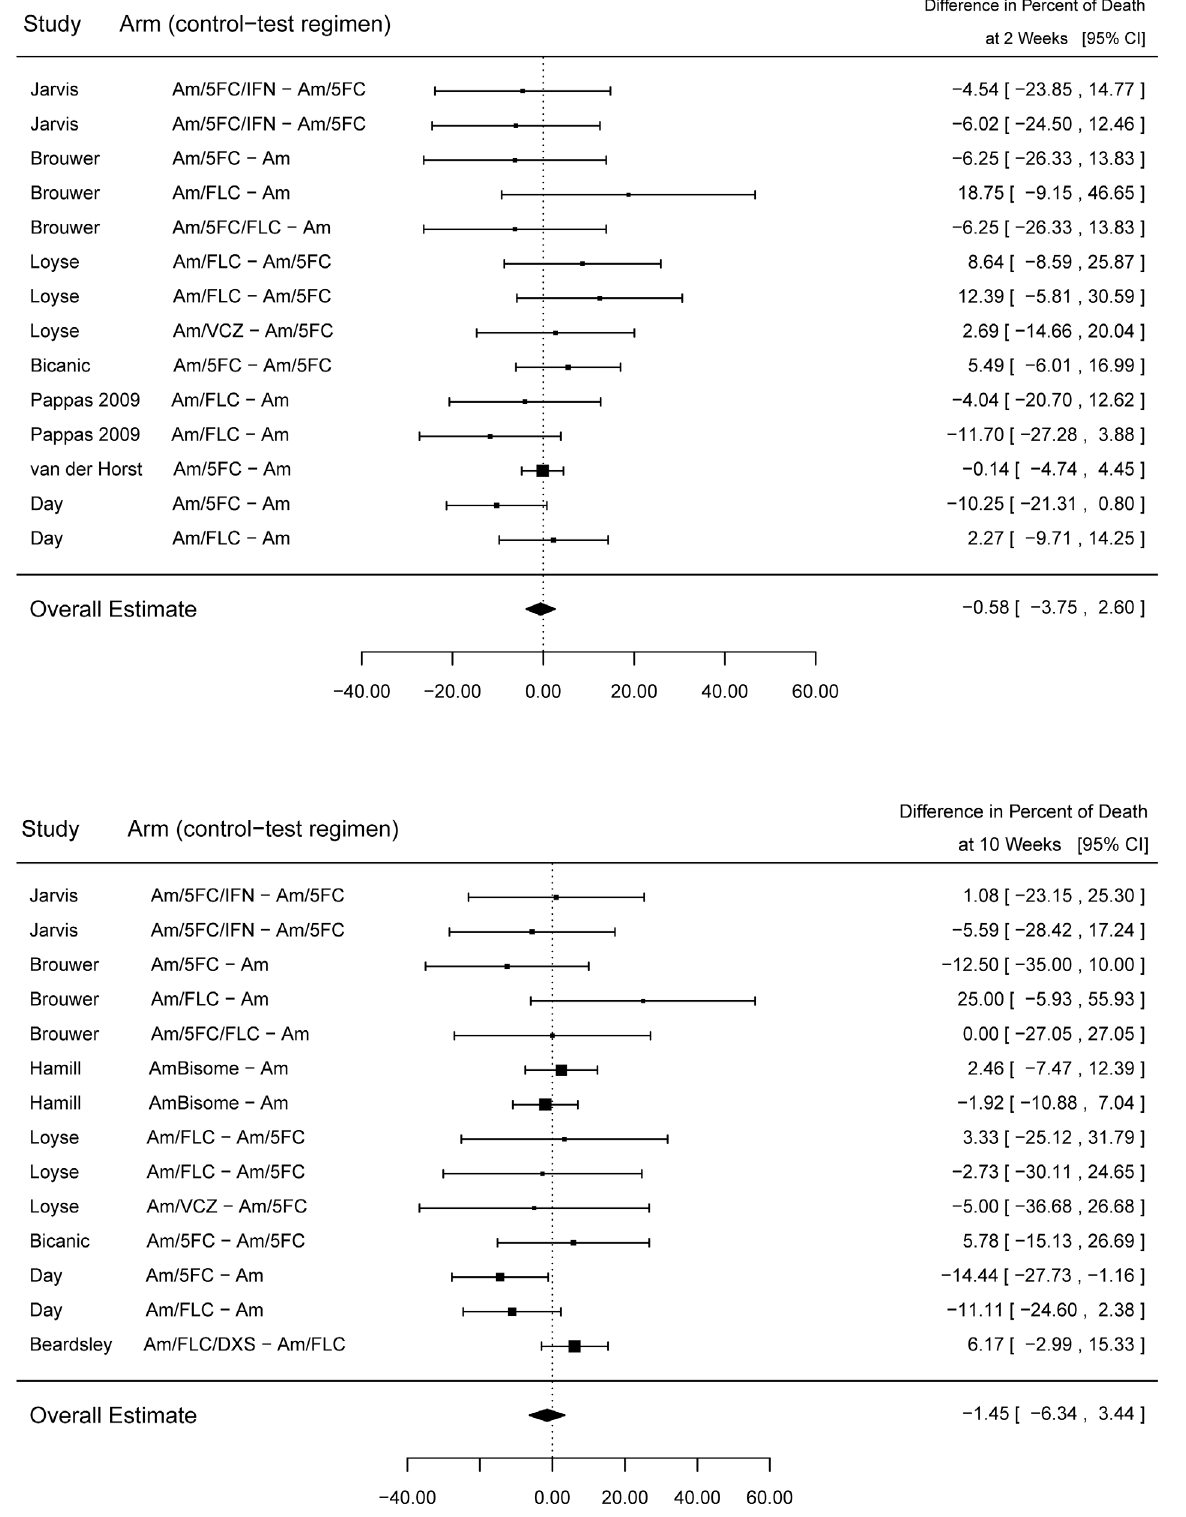
Fig 2. ACM differences between test and control groups at 2 weeks and 10 weeks. All studies with non-missing data are displayed. There are 7 studies and 21 arms.